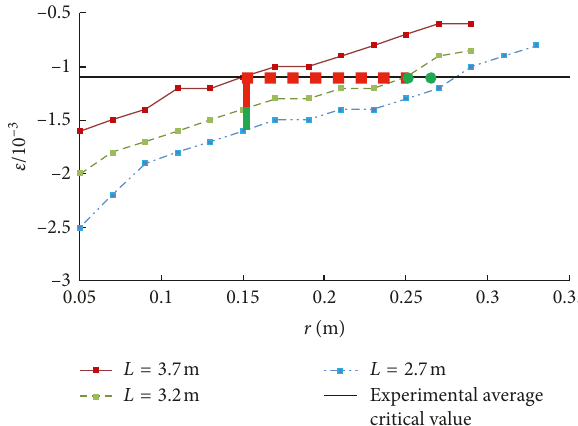
Figure 14: Evolution law of the rock element equivalent stress.